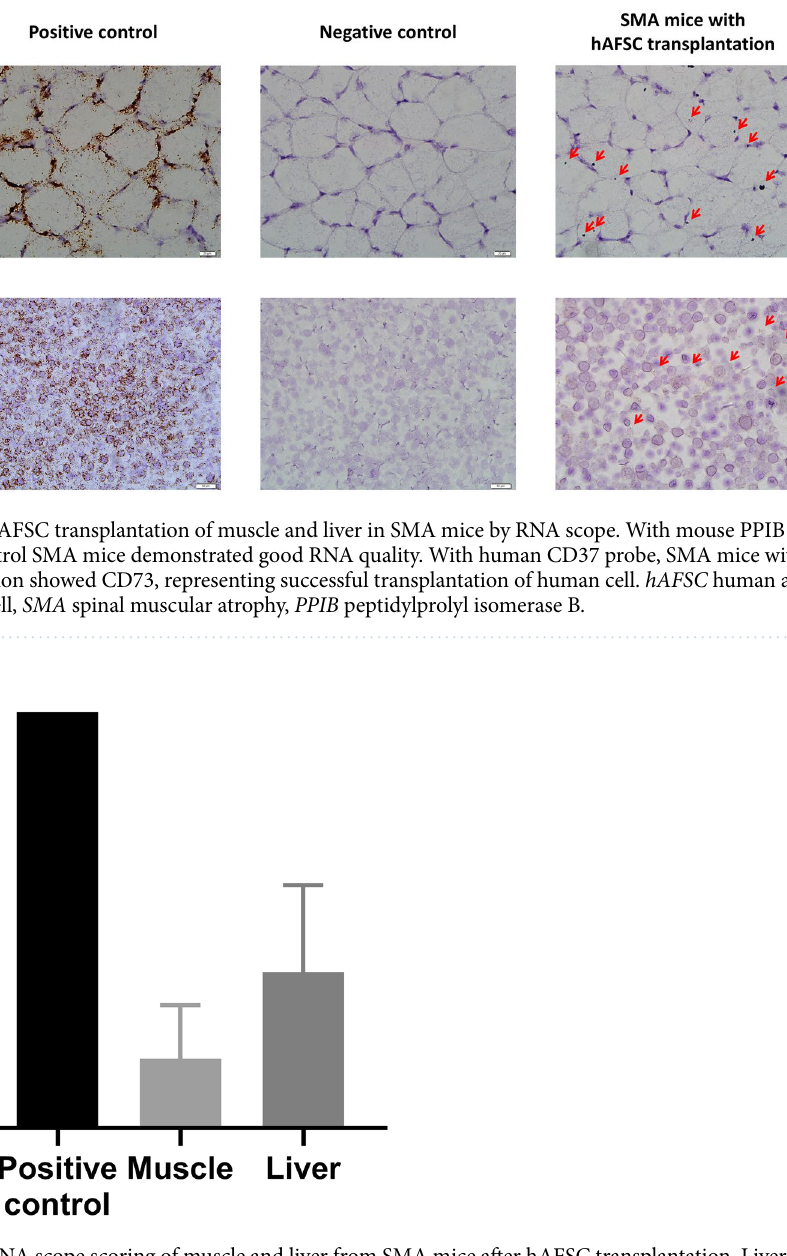
Figure 7. RNA scope scoring of muscle and liver from SMA mice after hAFSC transplantation. Liver expressed more CD73 than muscle. hAFSC human amniotic fluid stem